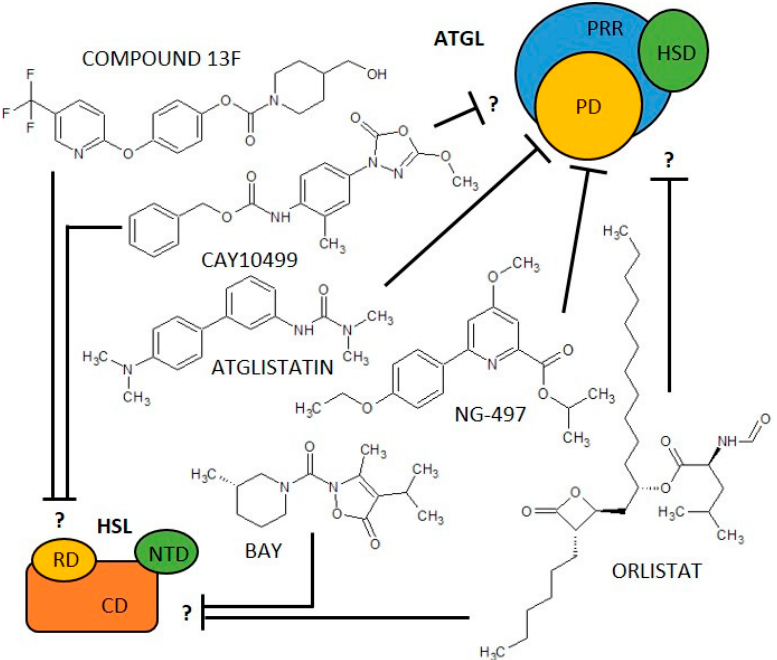
Figure 1. Scheme of adipose triglyceride lipase (ATGL) and hormone-sensitive lipase (HSL) struc- ture/domains and their inhibitors. ATLG domains: PD, Patatin-like Domain; PRR, Patatin Related Domain; HSD, Hydrophobic Stretch Domain. HSL domains: CD, Catalytic Domain; NTD, N-Terminal Domain; RD, Regulatory Domain. ? = it is not described which domain is